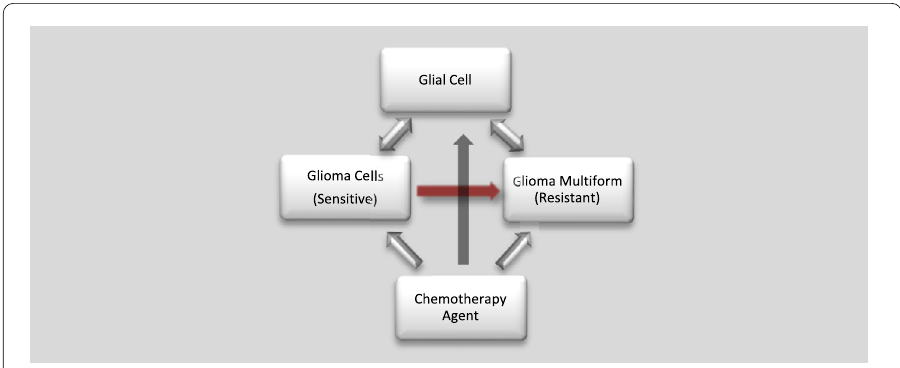
Figure 1 Schematic representation of the interaction between the glial cells and the tumor cells, the chemotherapy agent, and the mutation of the sensitive tumor cells to the resistant